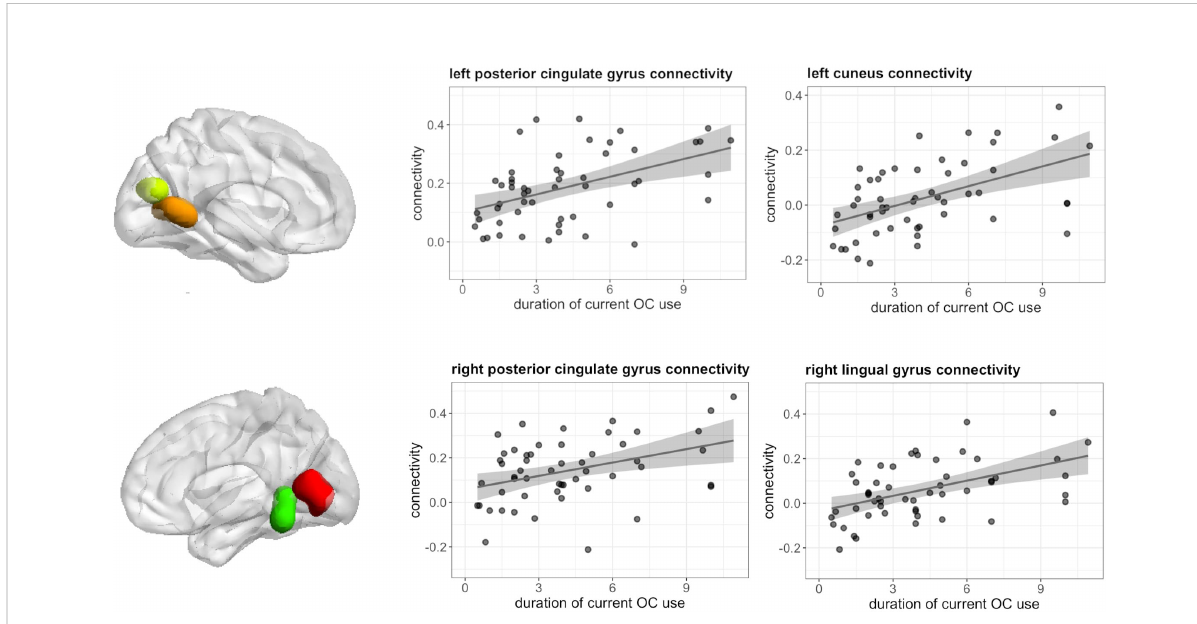
FIGURE 9 Positive association between duration of OC use and connectivity between left hippocampus and bilateral posterior cingulate gyrus, left cuneus and right lingual gyrus in current users during verbal fl uency.